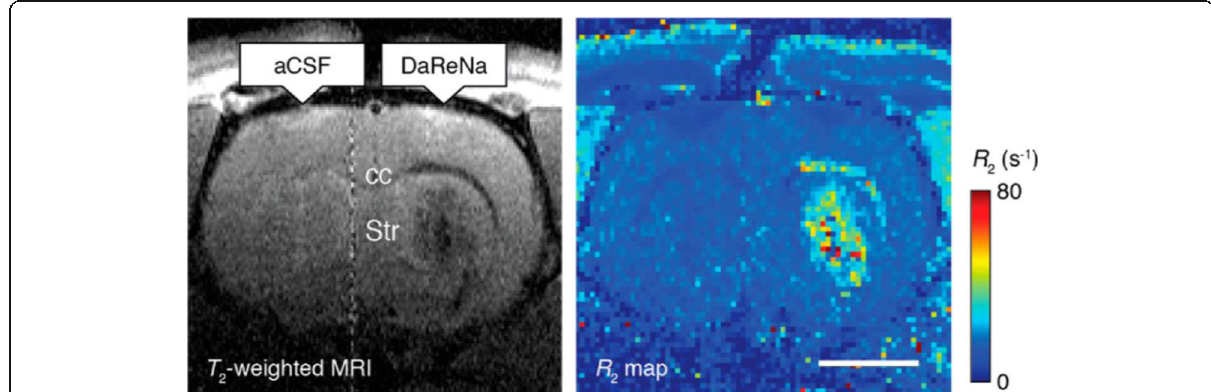
Fig. 2 MRI contrast agent. Infusion of the DaReNa, a dopamine sensor (BM3h) coated SPION complex, show the enhancement of contrast and relaxation near the injection site (striatum, Str) and along the corpus callosum (cc). Scale bar = 2 mm. Reprinted with permission from Hsieh et